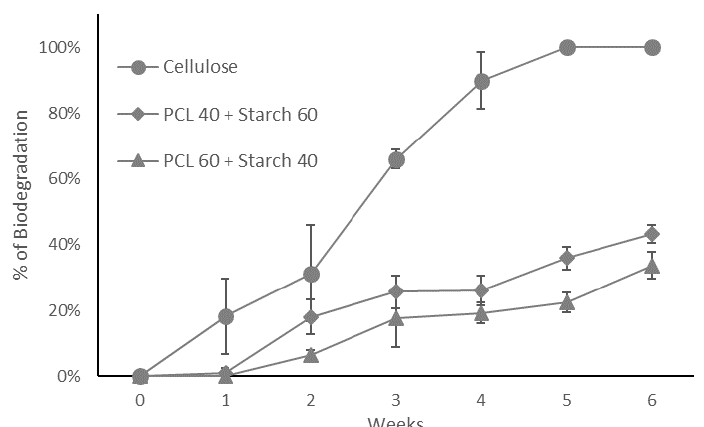
Figure 5. Cumulative biodegradation of selected samples and a positive (cellulose) control.